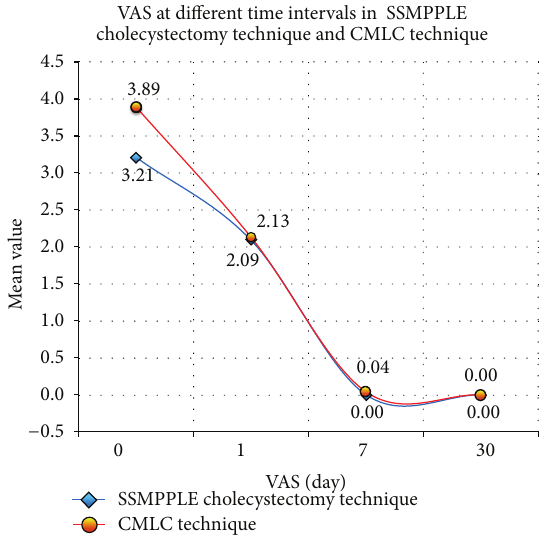
Figure 5: Visual Analogue Scale for the SSMPPLE cholecystectomy technique and the CMLC